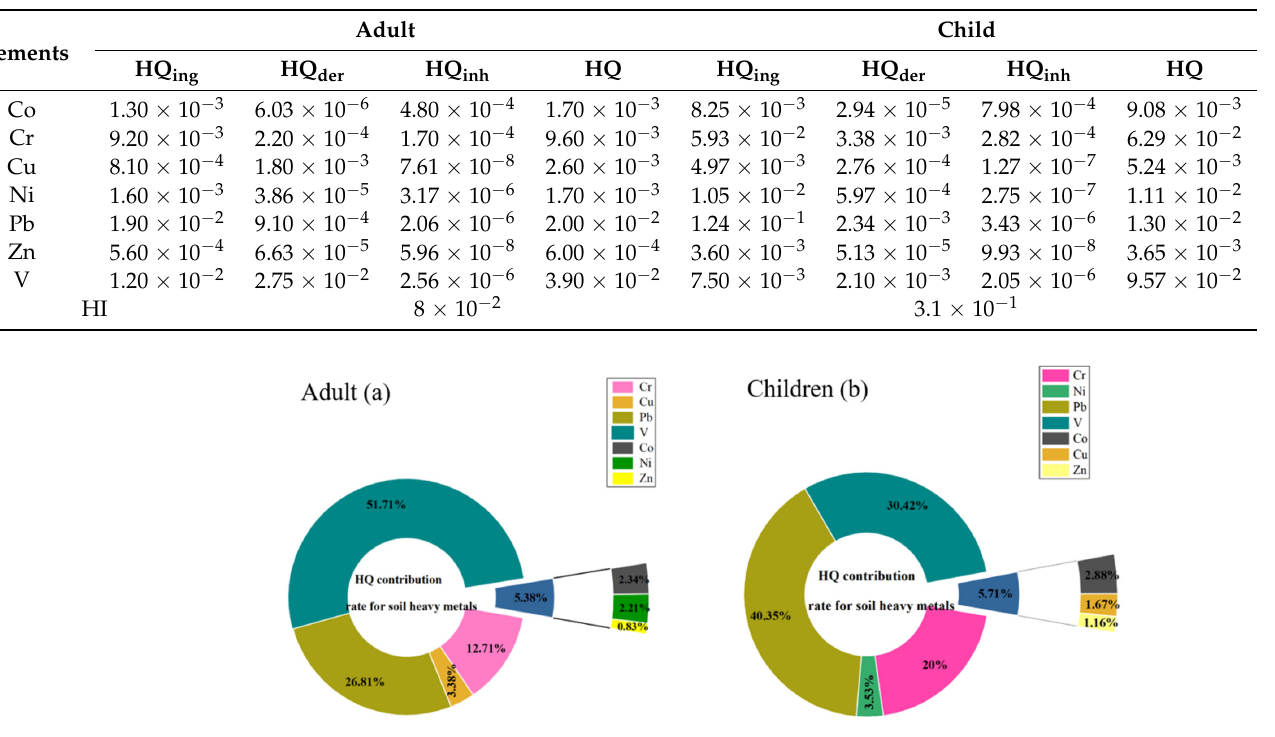
sources; Figure S5: The thematic map of the study area. (a) The surface coverage of the study area and the location of the mine sites. (b) The network of roads and waterway and distribution of factory